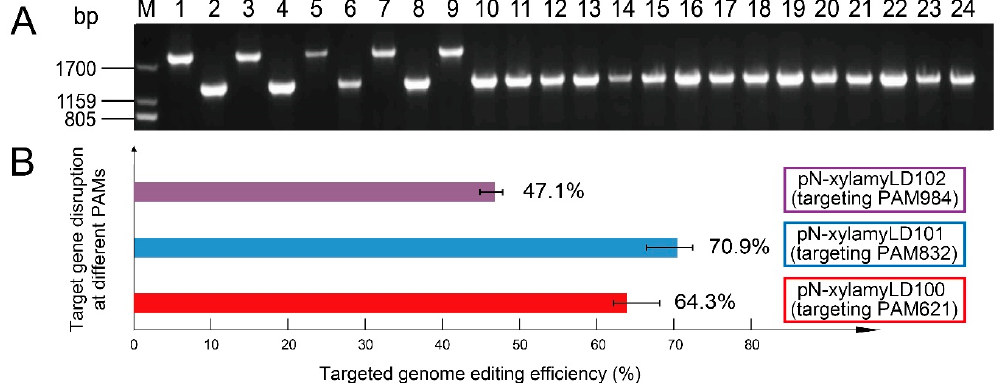
Figure 3. Confirmation of genome editing. Diagnostic PCR of the transformants. PCR products using randomly selected colonies as the templates were labeled as 1-24. The edited amyL gene generated smaller band sizes than the native gene. The sizes of the DNA markers are labeled on the left ( A ). The efficiencies of target gene disruption at PAM621, PAM832, and PAM984, which were calculated as the number of successfully edited colonies divided by the number of colonies obtained in the selection plates ( B ).